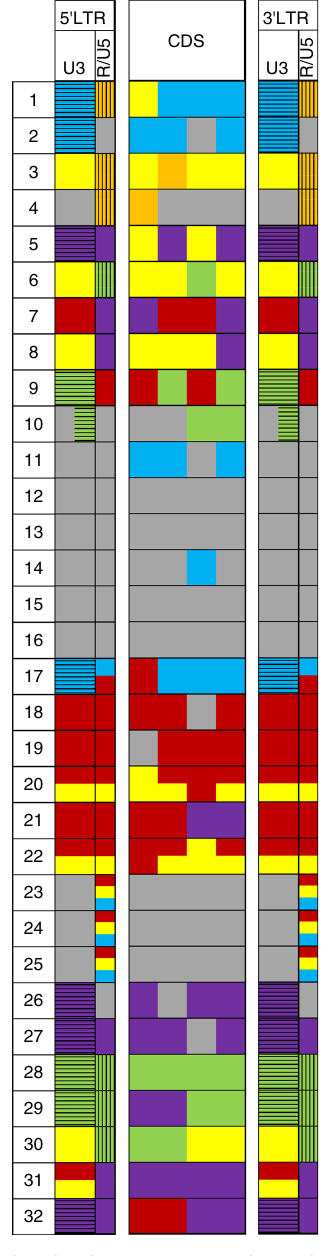
insertions recovered in the progeny of a heat-treated nrpd1-3 plant 8 . LTR domains are marked as U3 and R/U5. Informative SNPs and indels were used to infer the parental origin of LTRs. Several colours are used in the same area when polymorphisms were shared between more than one member. Colour code as in Fig.